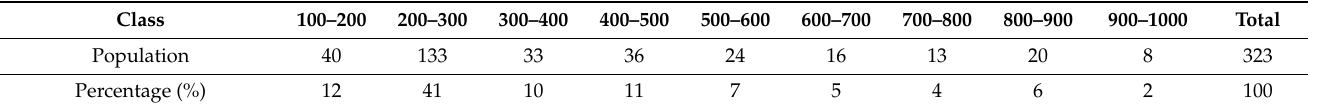
Figure 1. Relationship between the number of licensed beds and total floor area. Table 6. Population by class for stratified